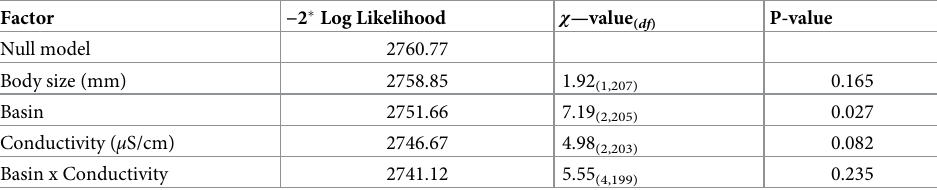
Table 1. ANOVA results from survival parametric analyses with Weibull distribution to three caddisfly popula- tions (Choapa, Maipo and Maule) exposed to low (180 μ S/cm), medium (500 μ S/cm) and high (1400 μ S/cm) con- ductivity levels, body size was used as a